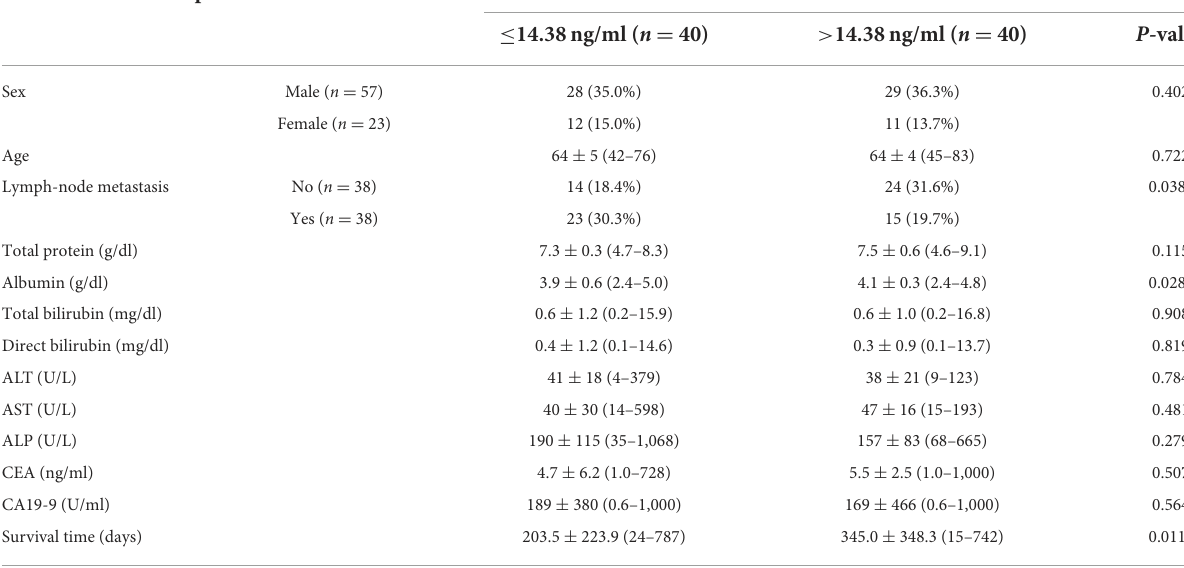
TABLE 3 The associations between serum PTPRS level and clinical